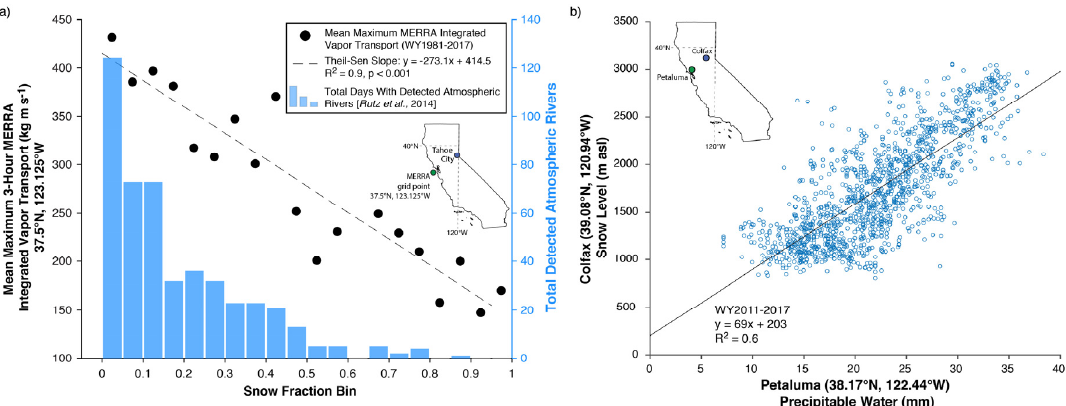
Figure 7. ( a ) (Left y ‐ axis): Scatterplot of mean maximum Modern Era Retrospective Analysis (MERRA) [42] integrated vapor transport (kg ∙ m ∙ s − 1 ) at an upstream grid point from Tahoe City (note inset maps) for each 0.05 (5%) bin of snow fraction (e.g., 0–0.49, 0.5–0.99, …). (Right y ‐ axis): Bar chart of total atmospheric rivers detected using the Rutz et al. [43] algorithm for each snow fraction bin. MERRA output used spans the period 1 January 1980 to 28 February 2017. ( b ) Scatterplot of observed precipitable water at Petaluma, California (near the California Coast) and snow level at Colfax, California between 2011 and 2017.